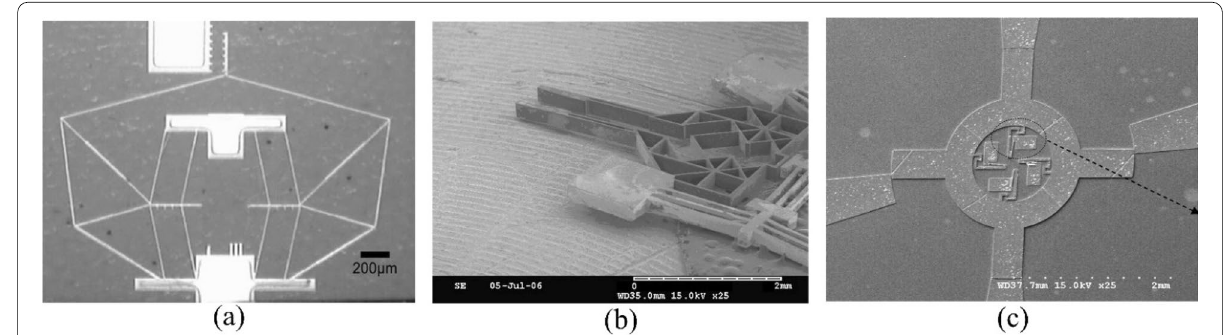
Figure 6 CMMs fabricated via electroplated Ni or NiFe: ( a ) Electrothermally-actuated compliant microtransmission fabricated using LIGA [57] (©Elsevier. Adapted by permission of Elsevier. Permission to reuse must be obtained from the rightsholder), ( b ) Microgripper fabricated from nickel, by Huang and Chen [72] (©IEEE. Adapted by permission of IEEE. Permission to reuse must be obtained from the rightsholder), ( c ) Compliant in-plane rotary bistable micromechanism fabricated from NiFe, by Luharuka and Hesketh [73] (©Elsevier. Adapted by permission of Elsevier. Permission to reuse must be obtained from the